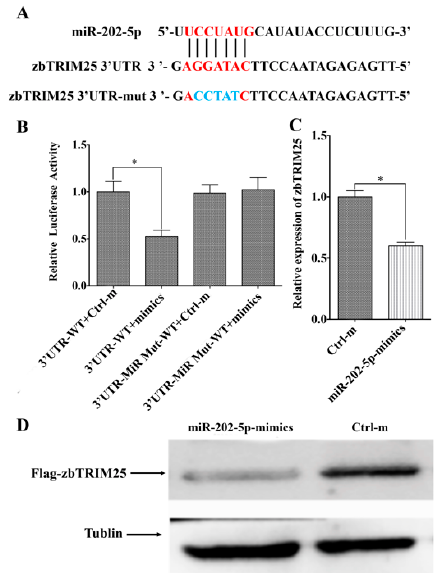
Figure 4. zbTRIM25 is the target of miR-202-5p. ( A ) The potential miR-202-5p binding sites in the zbTRIM25-3 (cid:48) UTR and its mutant. ( B ) miR-202-5p mimics and Ctrl-m were co-transfected into HEK 293T cells with luciferase reporter plasmid of wild-type zbTRIM25-3 (cid:48) UTR plasmid (3 (cid:48) UTR-WT) and mutant-type of zbTRIM25-3 (cid:48) UTR plasmid (3 (cid:48) UTR-miR Mut), respectively. ( C ) Overexpression of miR-202-5p in ZBE3 cells changes the zbTRIM25 mRNA level as measured by qRT-PCR. Asterisks indicate the significant di ff erences between groups (*: p < 0.05). ( D ), Enhanced miR-202-5p expression suppressed zbTRIM25 protein levels in HEK 293T cells. HEK 293T cells were co-transfected with miR-202-5p mimics or Ctrl-m and pCMV-Flag-zbTRIM25 or pCMV-Flag vector for 48 h and harvested for a Western blot analysis, respectively.